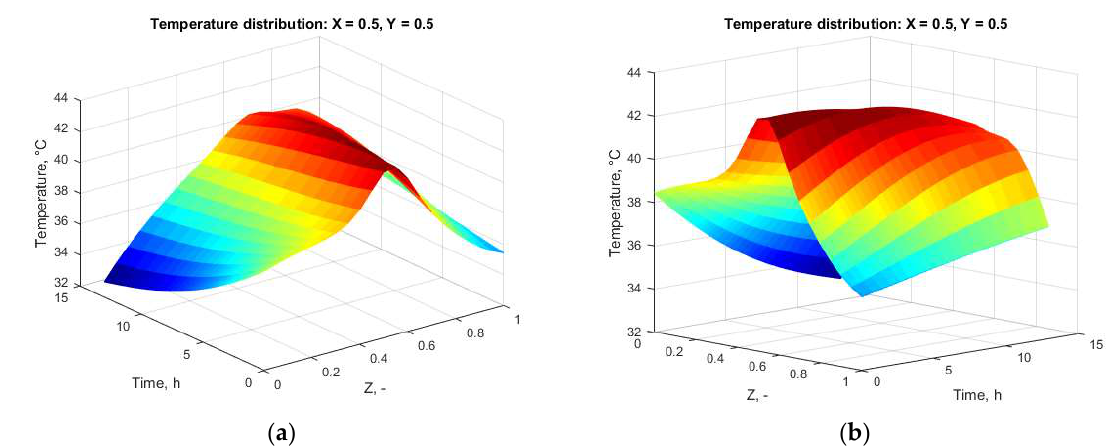
Figure 6. Temperature distribution in dimensionless function of deposit height and time for definite dimensionless value X = 0 and Y = 0 (according to Figure 2) obtained from the model MLP 4-7-1 network.